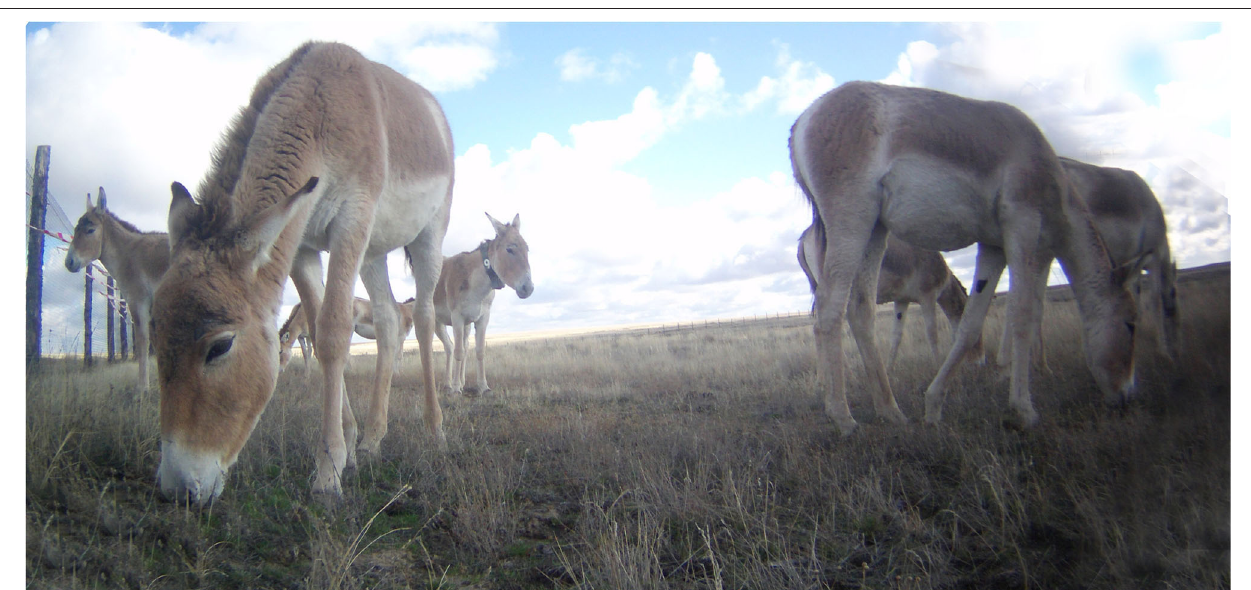
FIGURE 2 | Strong group cohesion and high movement correlation characterised the movement of kulan in the adaptation enclosure. Image taken by mare 26176’s camera collar.